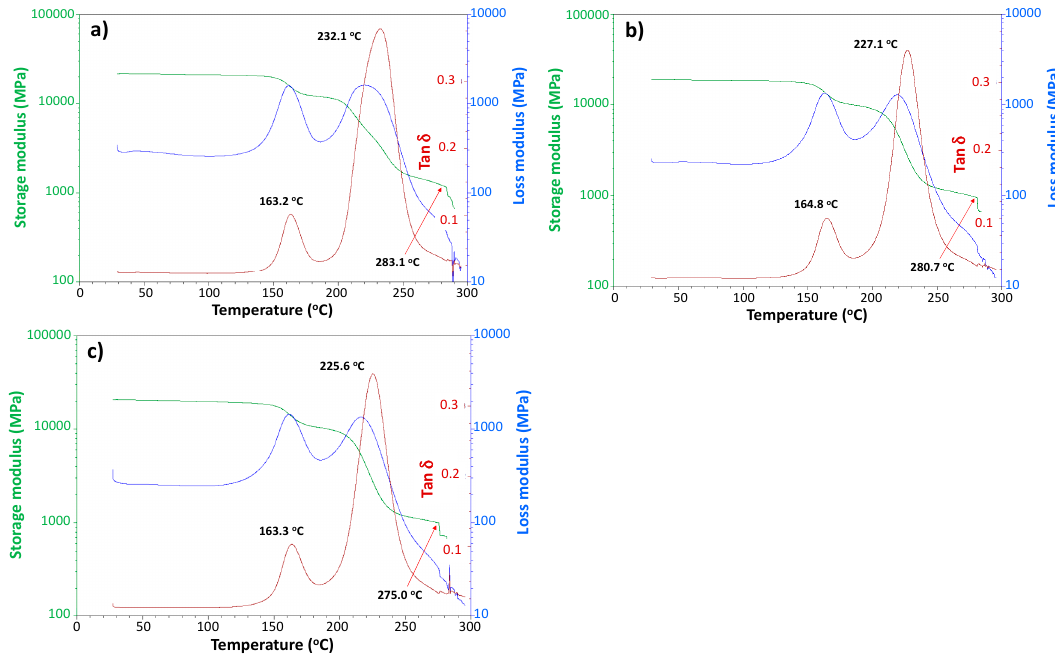
Figure 9. Dynamic mechanical analysis (DMA) charts for dry CFRP sample; ( a ) before moisture saturation and after; ( b ) the first (120 °C, 72 h); ( c ) third moisture saturation cycles. The red line indicates the position that noises are appeared due to the delamination of CF layers.